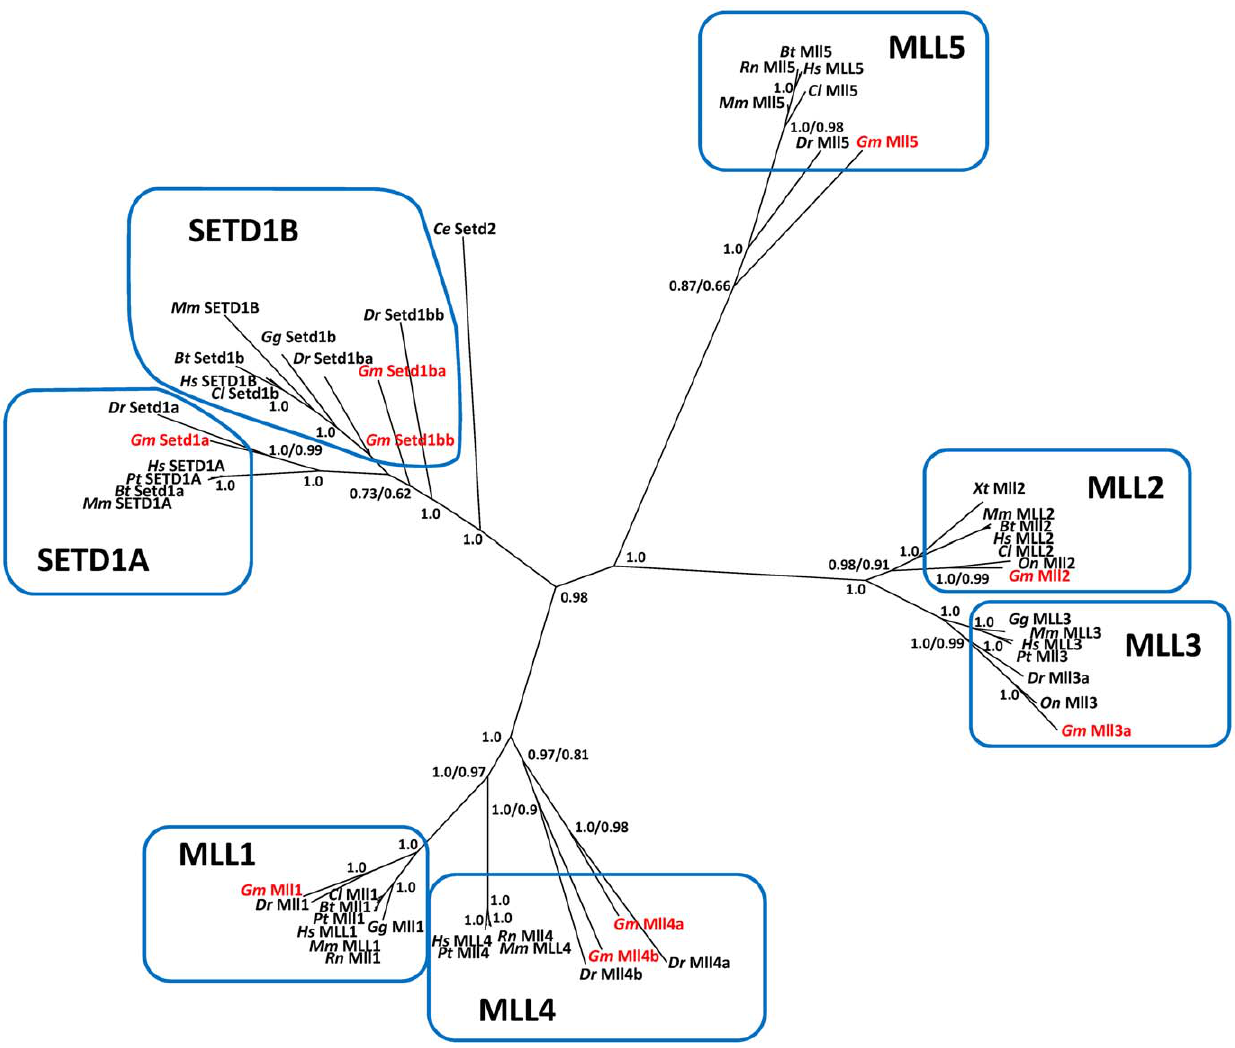
Figure 3. Phylogenetic tree of the seven mll and setd1 paralogues found in vertebrates. Numbers at the nodes indicate posterior probability and approximate likelihood-ratio values obtained from Bayesian (left) and maximum likelihood (right) methods, respectively. Species abbreviations are as follows: Bt, Bos Taurus; Ce, Caenorhabditis elegans; Cl, Canis lupus familiaris; Dr, Danio rerio; Gg, Gallus gallus; Gm, Gadus morhua; Hs, Homo sapiens; Mm, Mus musculus; On, Oreochromis niloticus; Pt, Pan troglodytes; Rn, Rattus norvegicus; Xt, Xenopus tropicalis. GenBank accession numbers for mll sequences are listed in Table S1.